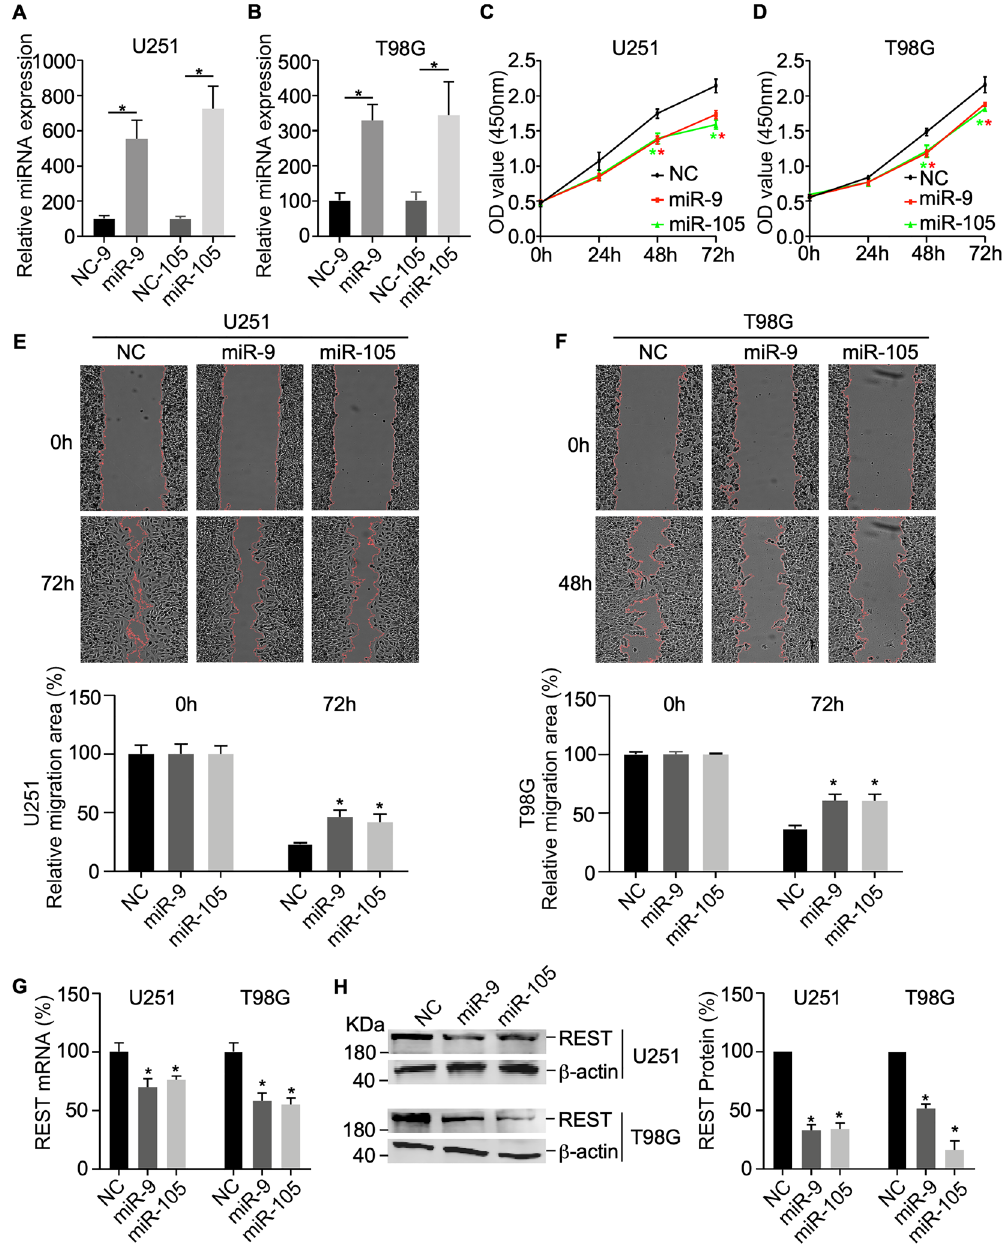
Figure 7. Experimental validation between REST and miRNAs. ( A , B ) The miRNA expression of miR-105-5p and miR-9-5p by transfection with miRNA-mimics in U251 and T98G cell lines. ( C , D ) Cell growth and proliferation were determined by CCK8 assay ( E , F ) Cell migration was determined by wound healing assay. The expression levels of REST mRNA ( G ) and protein ( H ) were determined by qRT-PCR and Western Blot (GraphPad Prism 9.3.1, https:// www. graph pad. com/ and ImageJ V1.8.0 software, https:// imagej. nih. gov/ ij/ index. html). These results are representative of three independent experiments with similar results. All data are shown as mean ± SD, * P value <